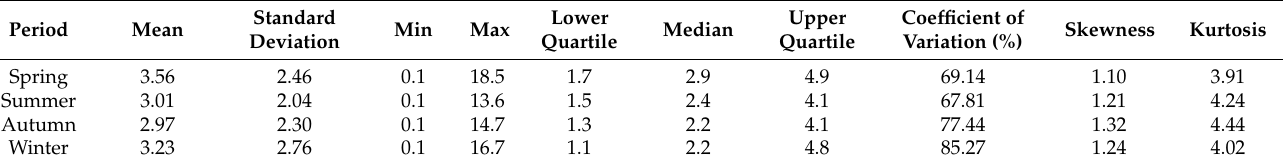
Table 2. Descriptive statistics of seasons.